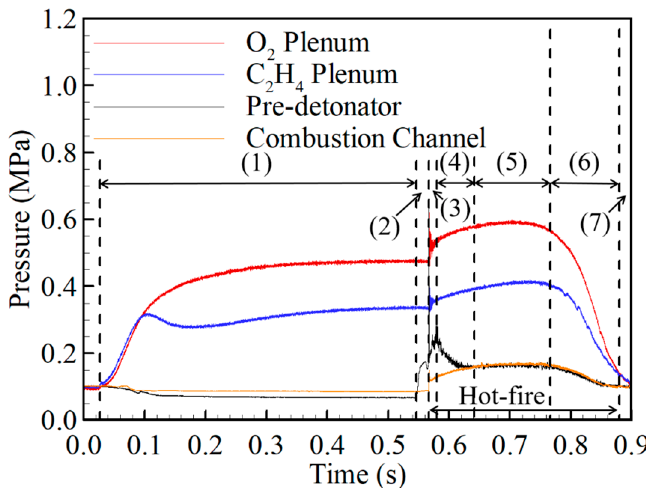
Figure 4. Pressure history with experimental events.